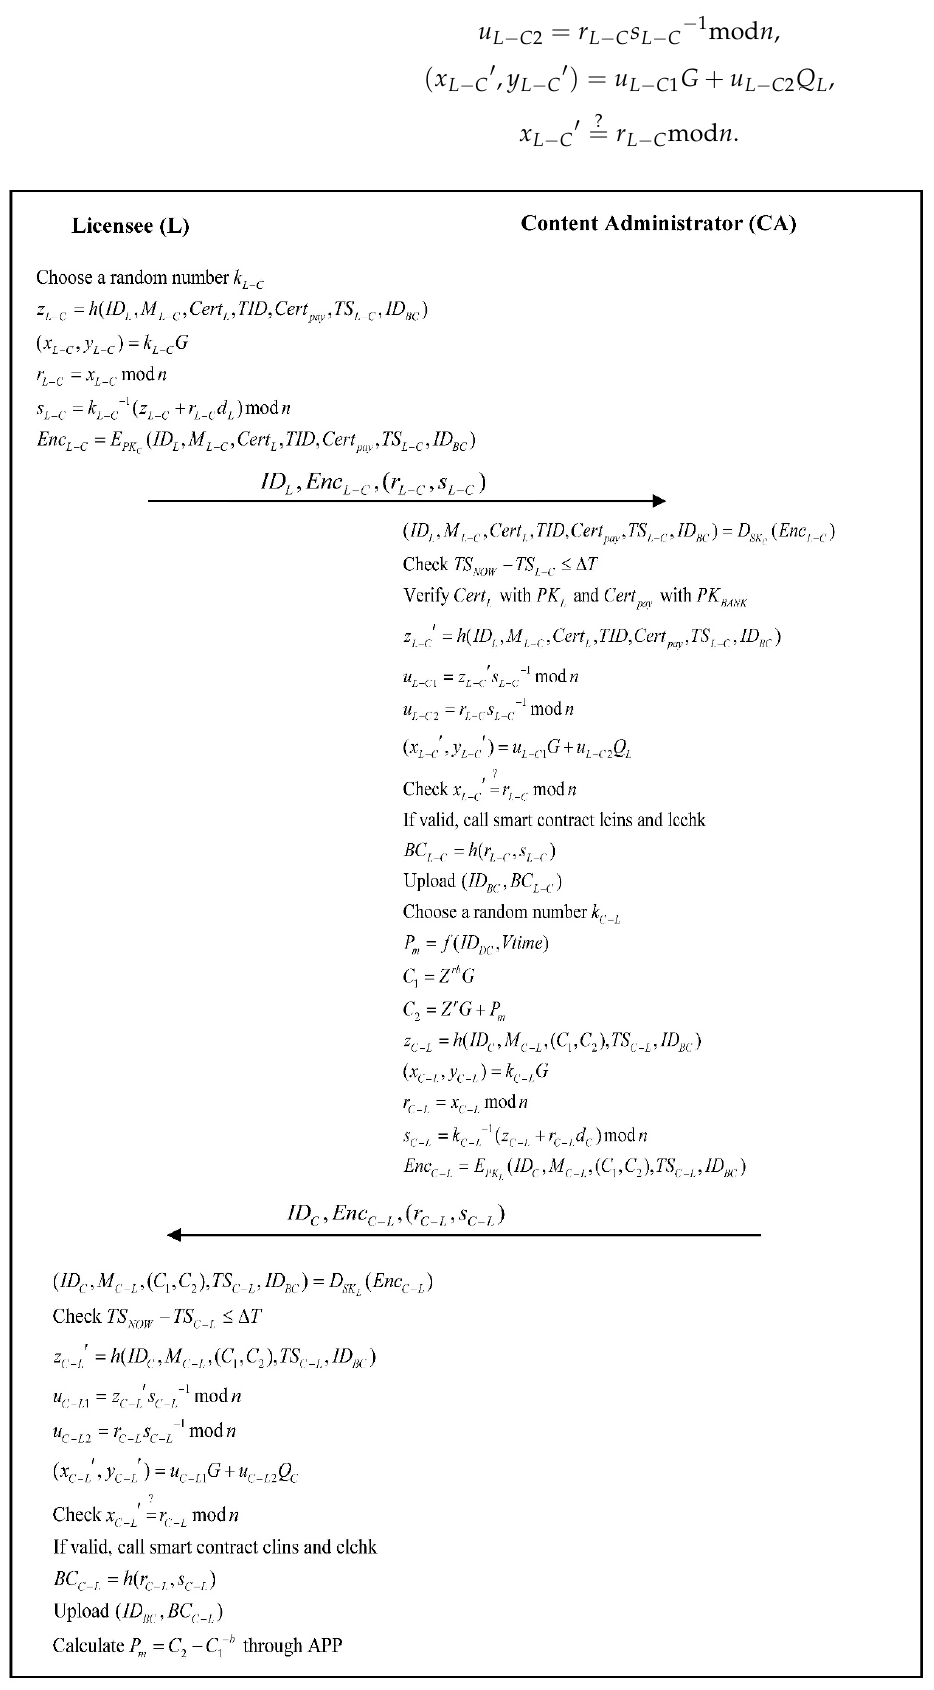
Figure 11. Payment verification and browsing phase (direct authorization).